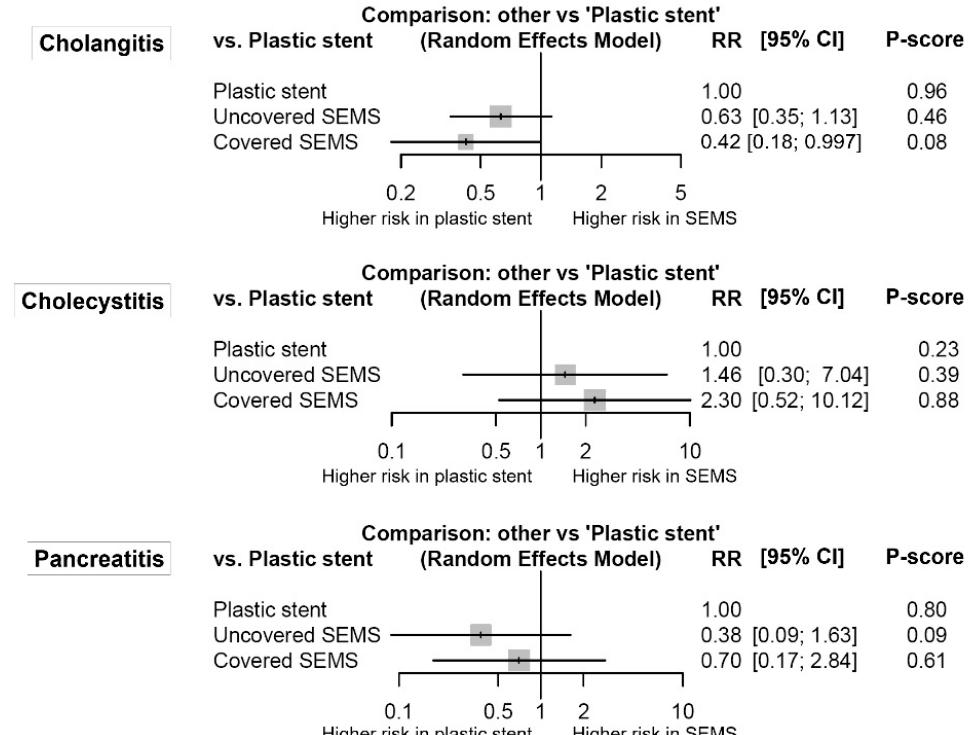
Figure 4. Comparative efficacy for stent-related inflammation according to the type of stents from the network meta-analysis. The P-score indicates the mean extent of certainty that one type of stent is better than another. SEMS, self-expandable metal stent; RR, risk ratio; CI, confidence interval.